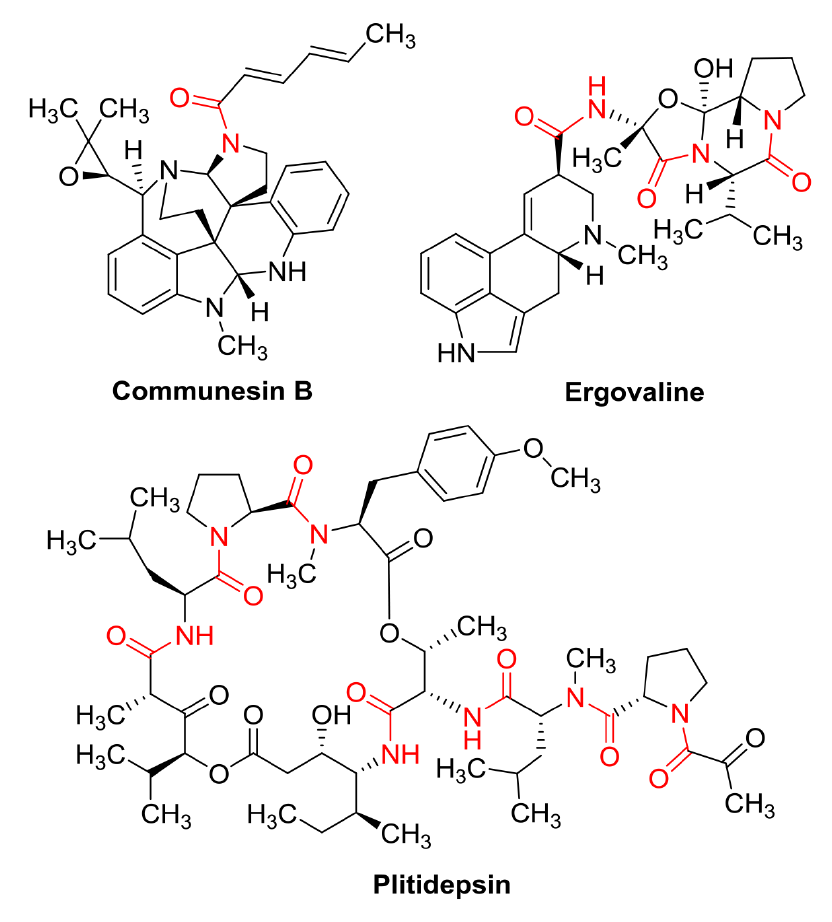
Figure 2: Examples of amide-containing natural